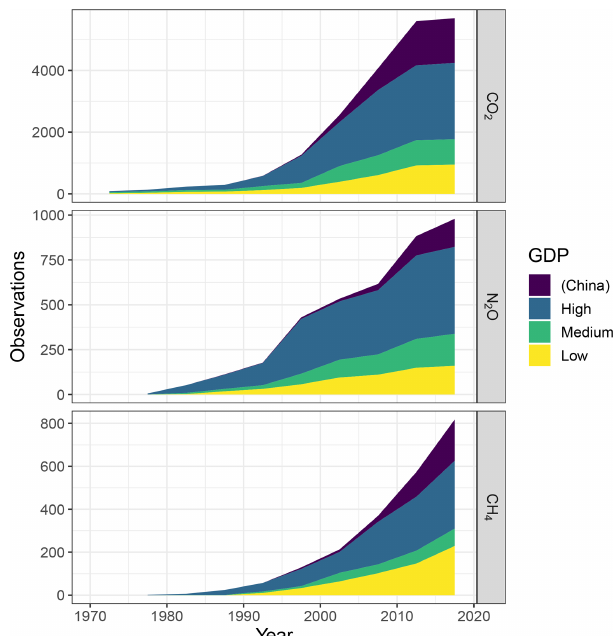
Figure 2. Cumulative observations of annual soil-to-atmosphere flux of greenhouse gases (CO 2 , N 2 O, and CH 4 ) over time. An ob- servation indicates a set of measurements that resulted in an an- nual flux estimate. Colors show fraction of observations made in countries with high (top third), medium, and low (bottom third) per capita gross domestic product (GDP, listed by the World Bank) in the year of measurement. The People’s Republic of China is broken out separately, as this country has a unique combination of large numbers of observations, high GDP, and large popula- tions and thus low per capita GDP. Note differing y -axis scales in each panel. Data source: CO 2 – Jian et al. (2021); N 2 O – Global N 2 O Database (https://ecoapps.nrel.colostate.edu/global_n2o/, last access: 5 February 2022); and CH 4 – Al-Haj et al. (2020), Han and Zhu (2020), Tan et al. (2020), Gatica et al. (2020), and Feng et al. (2020).